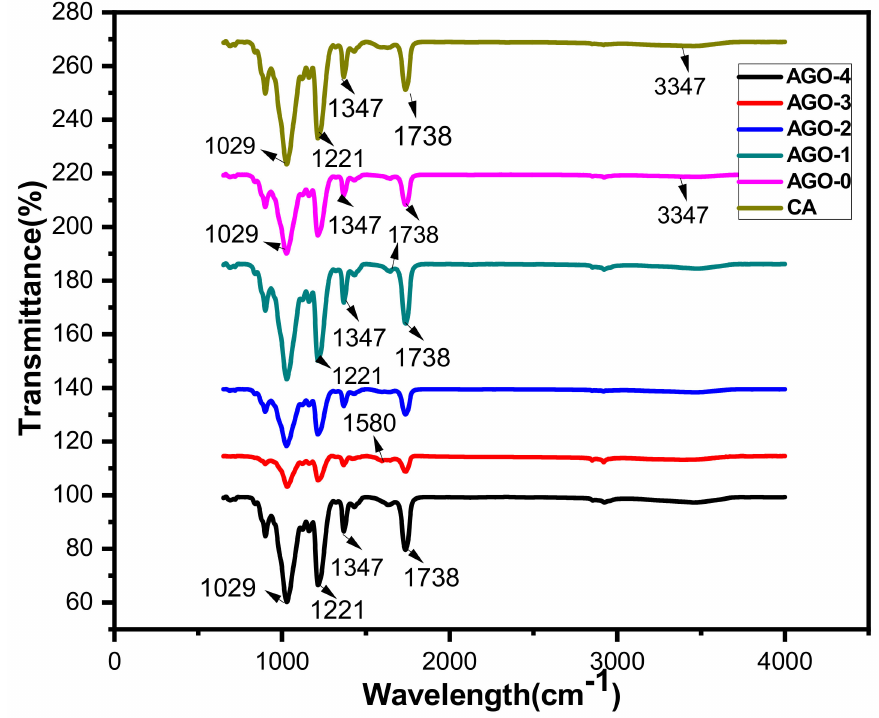
Figure 3. FTIR spectrum of AGO